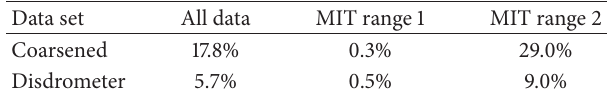
Table 1: Summary data associated with exploring the rain event definition parameter space. Values shown indicate percentage of parameters characterized as “plausible,” as described in the text. MIT range 1 is associated with MIT values starting at 1 minute, incrementing by 1 minute, and ending at 90 minutes. MIT range 2 is associated with MIT values starting at 5 minutes, incrementing by 5 minutes, and ending at 12 hours. Data set All data MIT range 1 MIT range 2 Coarsened 17.8% 0.3% 29.0% Disdrometer 5.7% 0.5% 9.0%